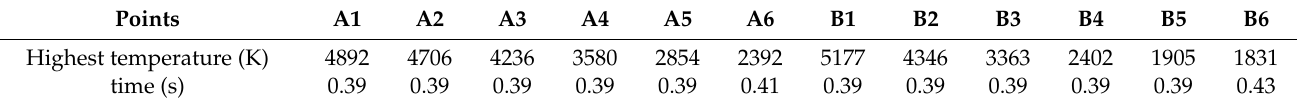
Figure 9. The thermal history of the sampling points on the Q235 side. Table 6. The highest temperatures and the corresponding times of the sampling